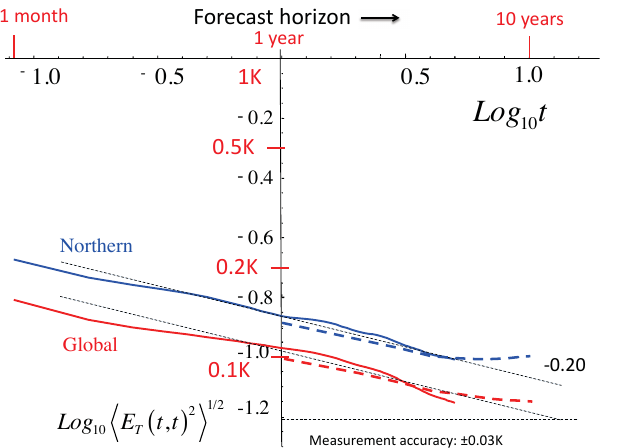
Figure 6. A log-log plot of the standard deviations of the anomaly hindcasts, with the theoretical reference line corresponding to H =− 0.20. The solid lines are for the monthly data, the dashed lines for annual data. Red indicates global data; blue indicates Northern Hemisphere data.